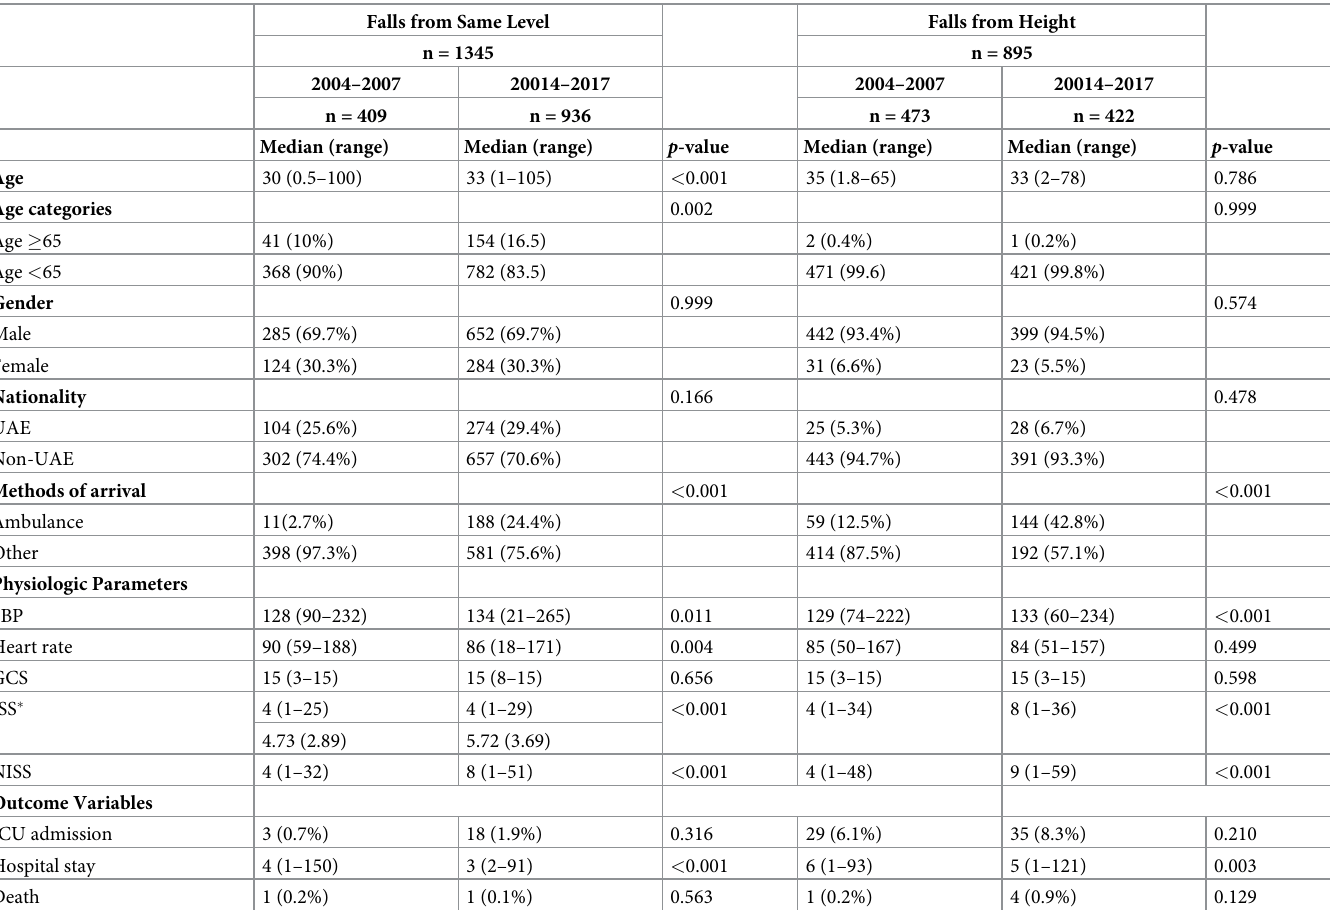
Table 4. Comparison of the mechanism of fall-related injuries during the first (2003–2006) and second period